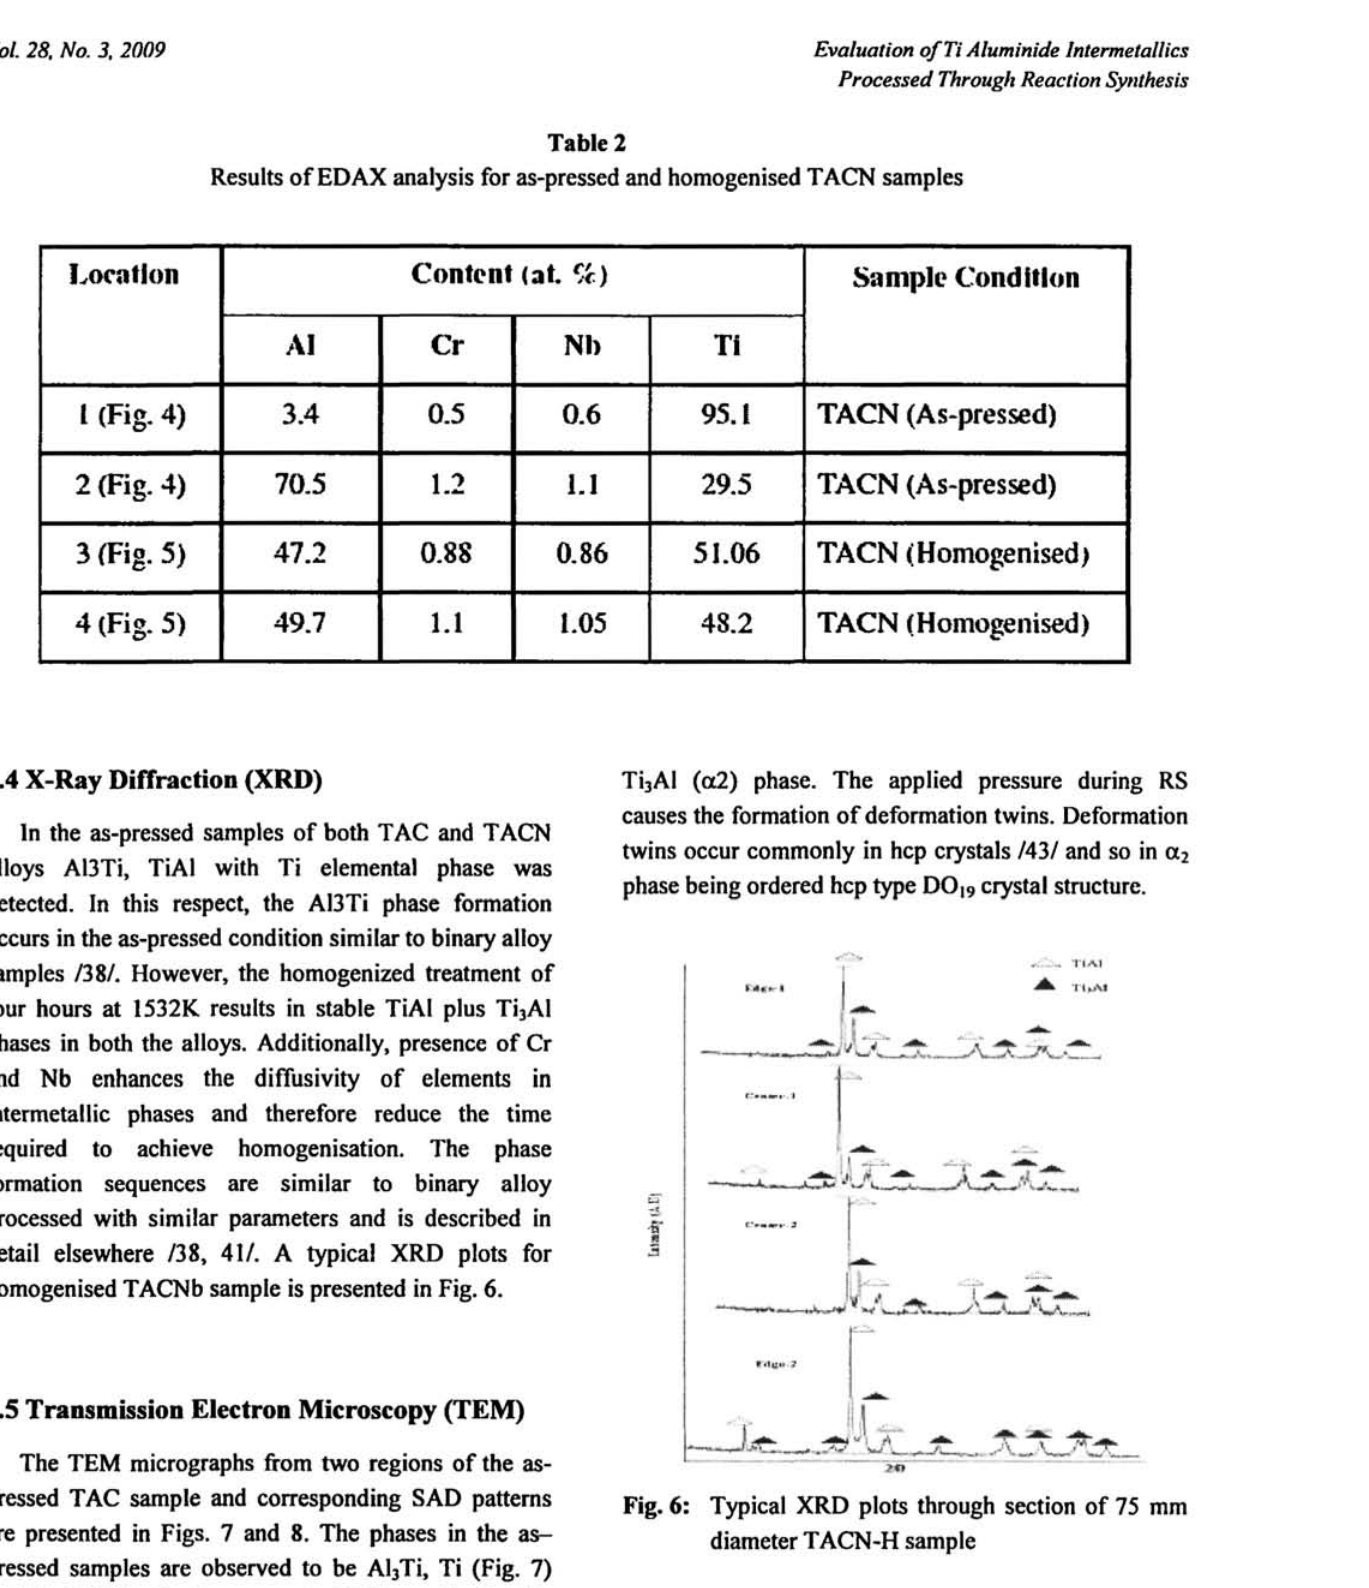
Fig. 6: Typical XRD plots through section of 75 mm diameter TACN-H